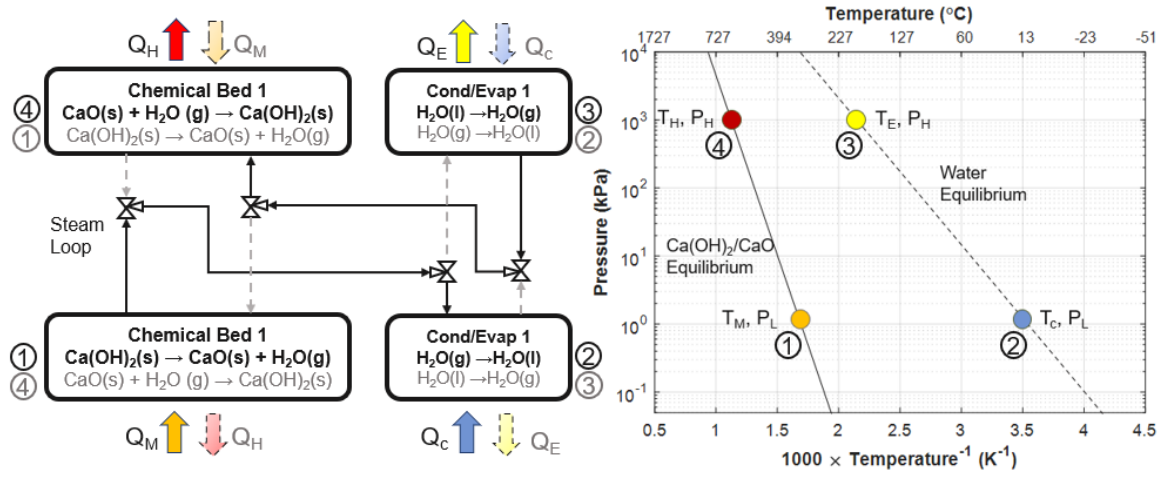
Figure 3. ( a ) Schematics of components of Ca(OH) 2 /CaO ChHP system; ( b ) Clausius–Clapeyron di- Figure 3. Schematics of components of Ca(OH) 2 /CaO ChHP system; Clausius–Clapeyron diagram agram ( ① – ④ are the reaction conditions corresponding to the figure on the left) . ( 1 (cid:13) – 4 (cid:13) are the reaction conditions corresponding to the figure on the